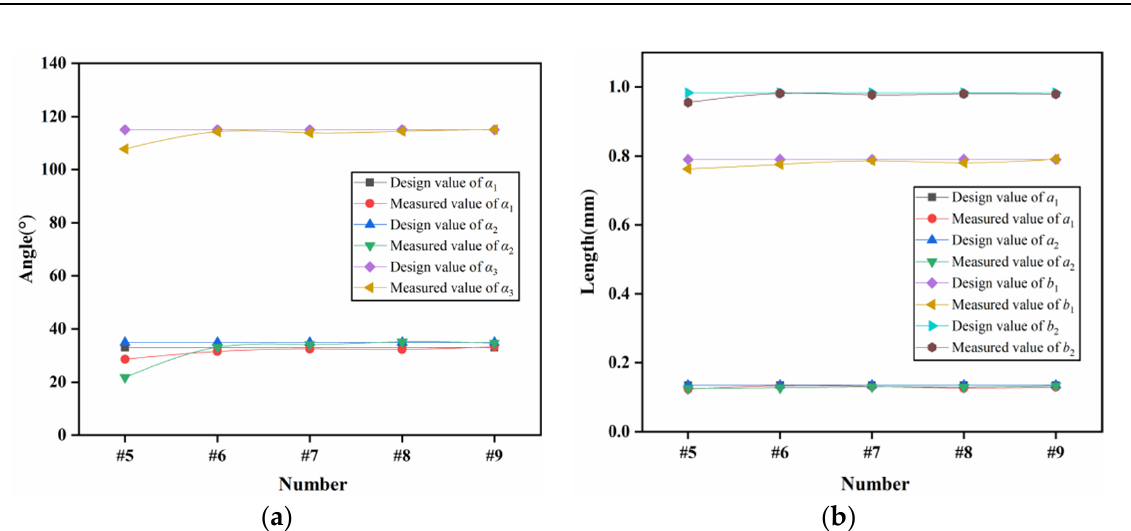
Figure 25. Test results of prototype #5.